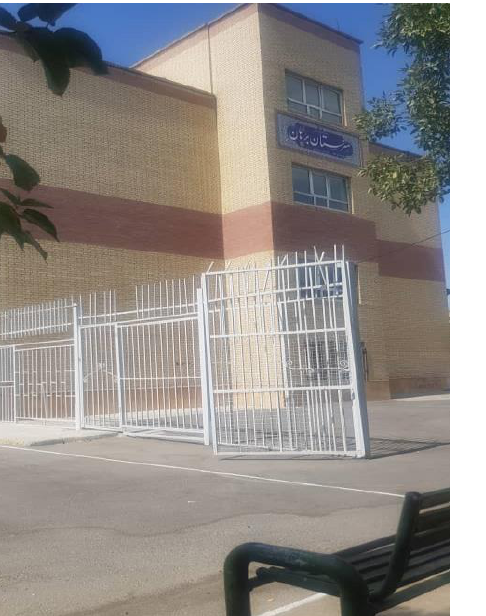
Figure 5. Temperature change in Tehran.